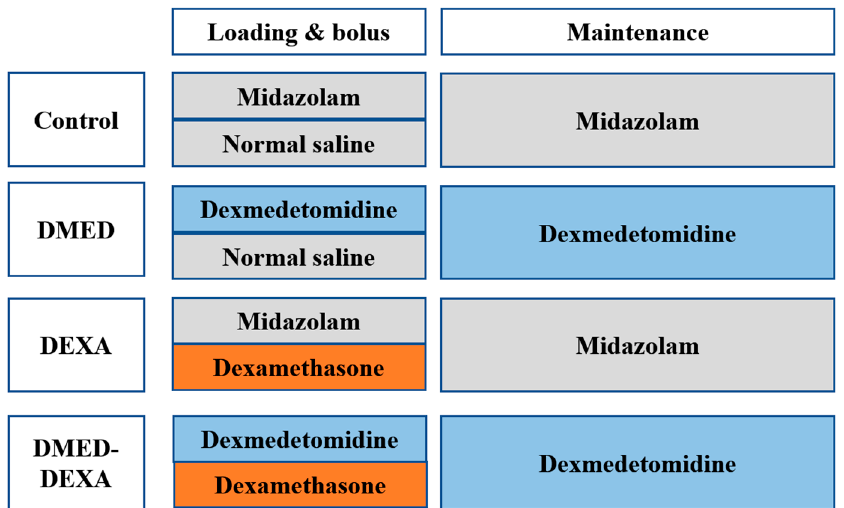
Figure 1. Schedule of drug administration to patients in the four study groups. Patients in the Control group received a 2 mL bolus of normal saline, followed by infusion of midazolam (0.05 mg/kg loading dose and a 20 µg/kg/h continuous dose). Patients in the DMED group received a 2 mL bolus of normal saline, followed by infusion of dexmedetomidine (1.0 µg/kg loading dose and a 0.4 µg/kg/h continuous dose). Patients in the DEXA group received a 2 mL bolus of dexamethasone, followed by infusion of midazolam. Patients in the DMED-DEXA group received a 2 mL bolus of dexamethasone, followed by infusion of dexmedetomidine.